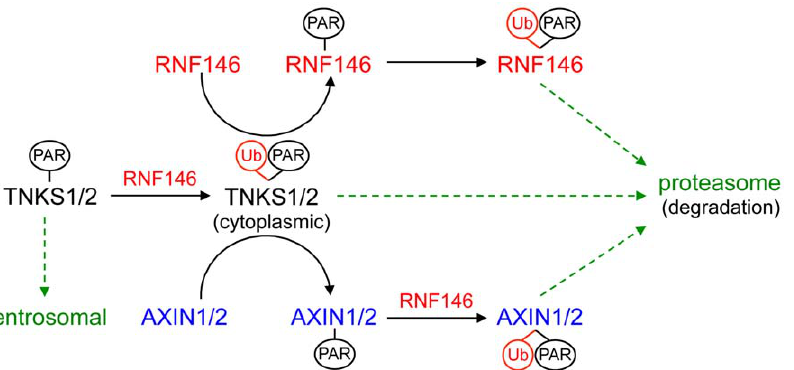
Figure 8. Model of RNF146 activity that leads to degradation of tankyrase, Axin, and RNF146 proteins. See Discussion for details. Green arrows indicate protein relocalization. ‘‘Ub’’ indicates ubiquitylation and ‘‘PAR’’ indicates PARsylation of the indicated proteins.